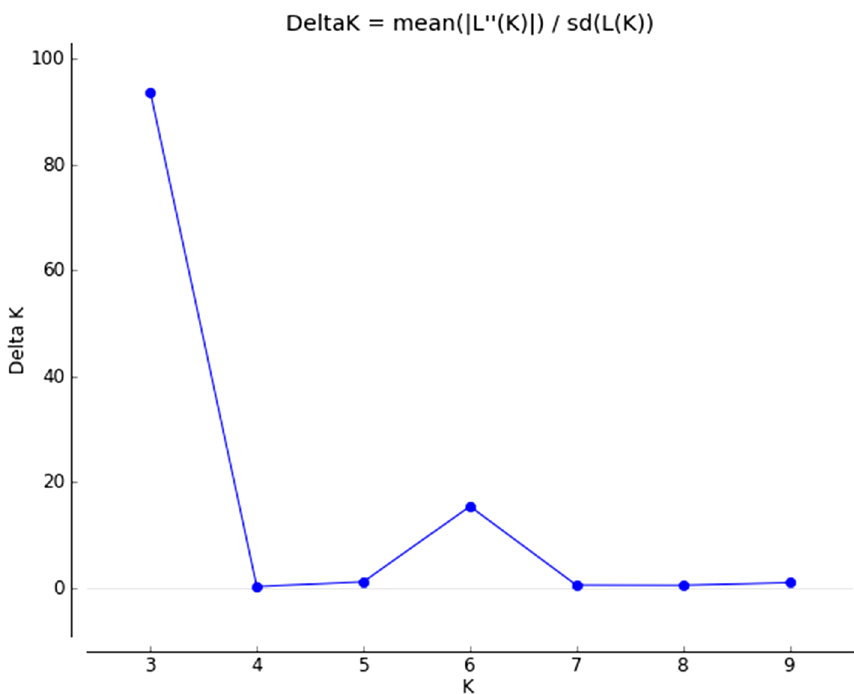
Figure 6. Estimation of ΔK value obtained with STRU CTU RE analysis.